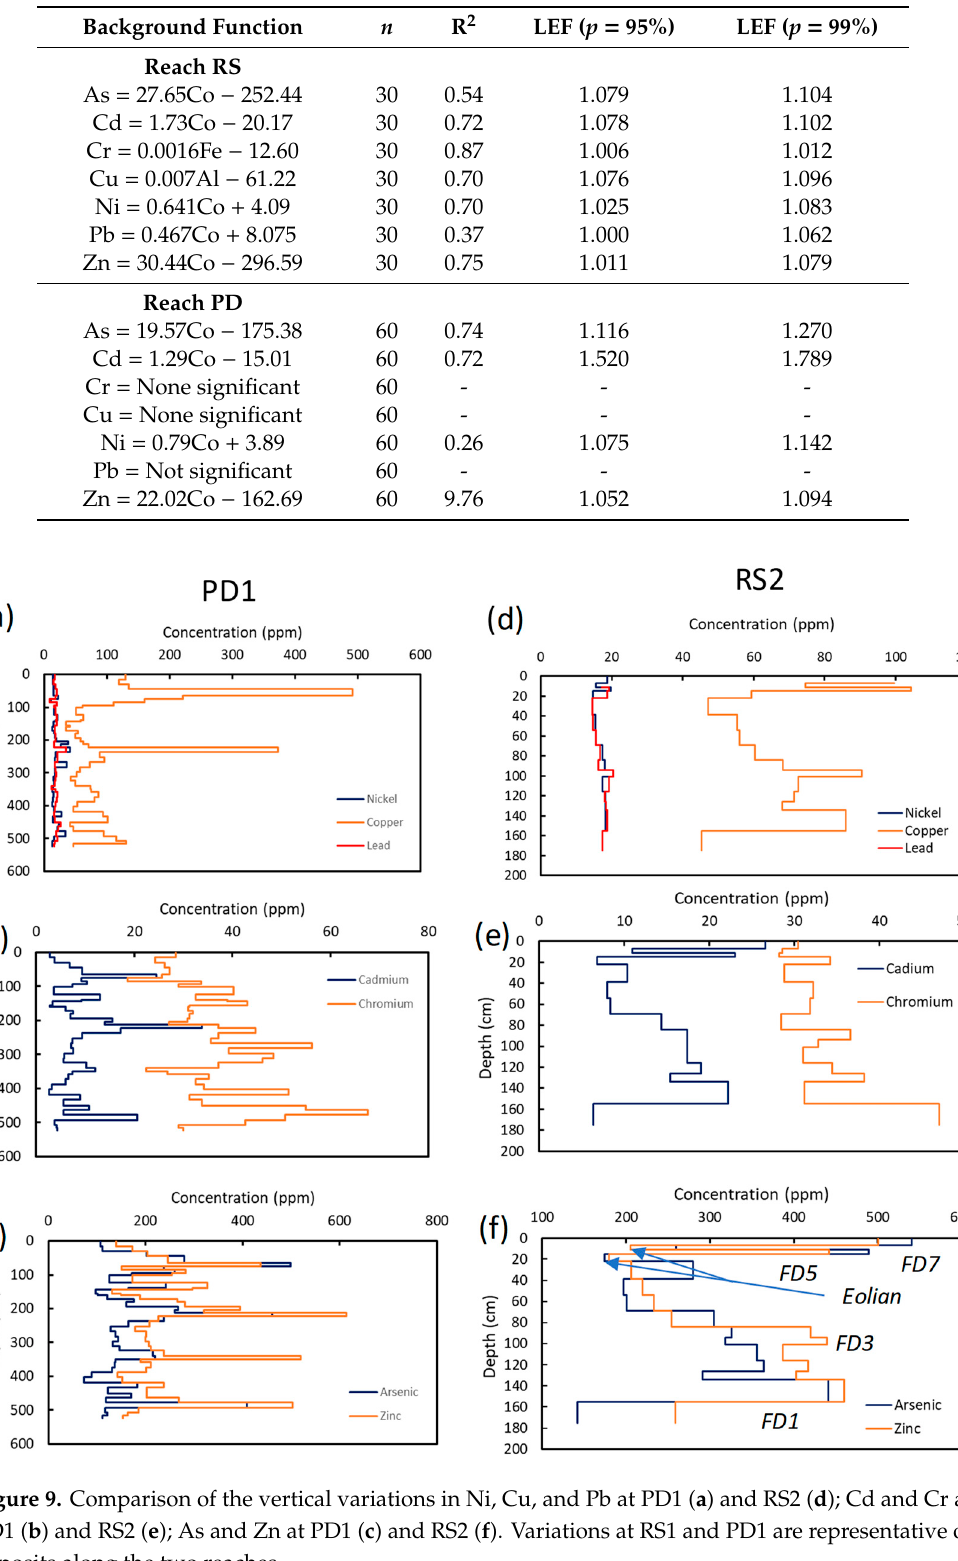
Table 4. Background functions for selected trace metals. Concentrations are those associated with < 63 µ m sediment fraction and are shown in mg / kg; n is total number of samples. Threshold local enrichment factor (LEF) is the value above which the sample is likely to exceed natural variability at a given probability ( p ).